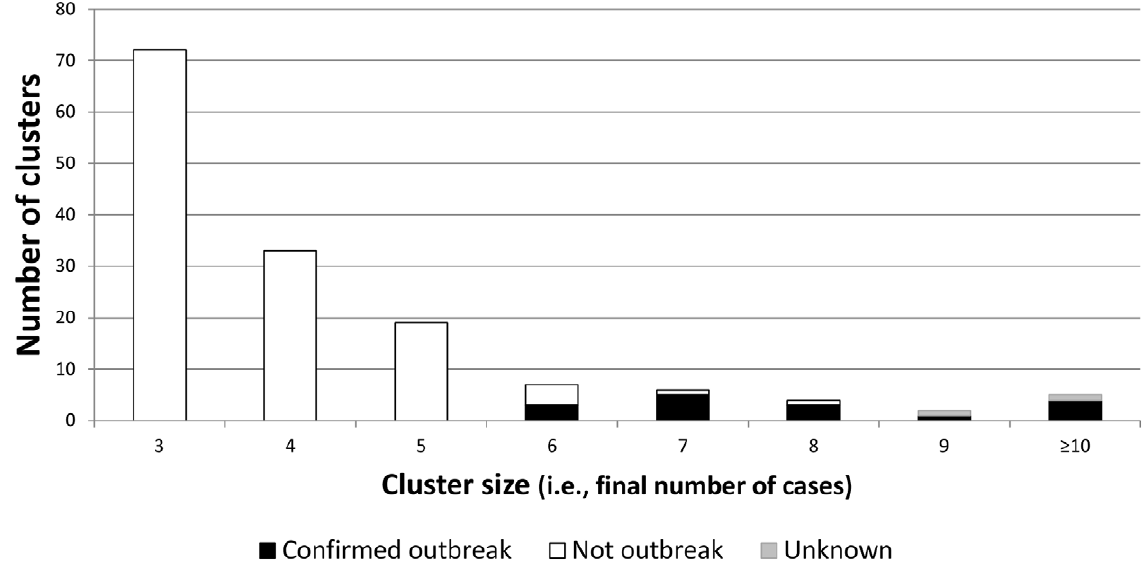
Figure 1. Distribution of 148 cohort clusters, by number of cases and outcome. Cohort composed of incident tuberculosis genotype clusters of 3 or more cases identified by SaTScan from 2006 to 2010, meeting inclusion criteria. Clusters with 10 or more cases are grouped into one bar. Outcome of the cluster could be confirmed as an outbreak, confirmed as not an outbreak, or unable to be confirmed (uncertain).